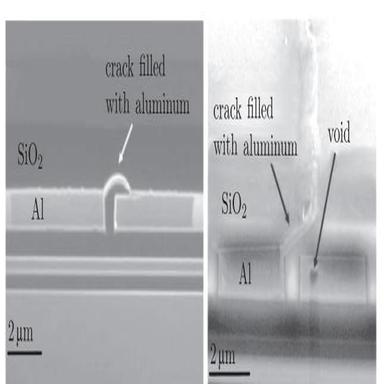
The right hand side diagram shows the temperature history within the conductor paths. After an initial homogeneous cooling from 498 K to 398 K, 50 inhomogeneous thermal load cycles are applied reaching a maximum temperature of 653 K. The left image illustrates the temperature distribution after heating. Figure adopted from.